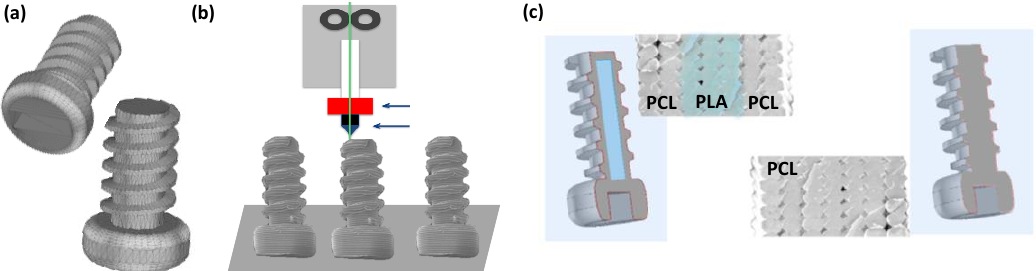
Figure 2. Strategy followed for the preparation of 3D-printed structures with internal and external porosity: ( a ) design: CAD software, ( b ) fabrication: additive manufacturing (AM), ( c ) structure and materials employed for the two different prototypes.